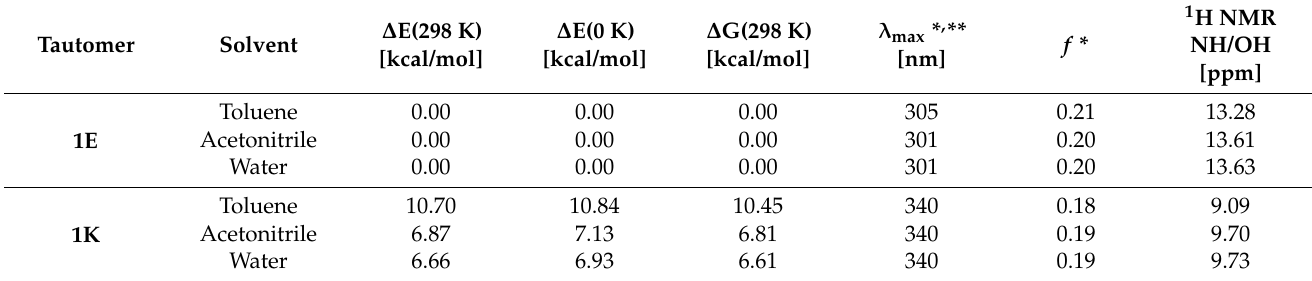
Table 1. Theoretically predicted (M06-2X/def2-TZVPPD) relative stability and spectral characteristics of the most stable tautomeric forms of favipiravir.